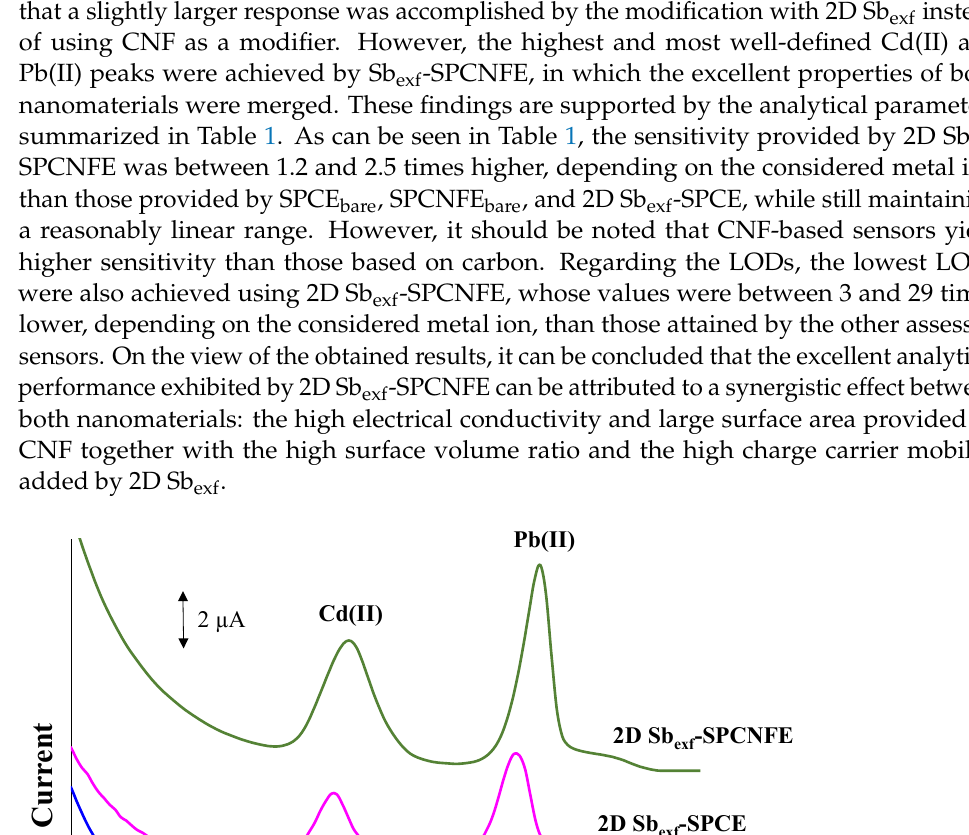
Figure 5. DP stripping voltammograms of 55 µg L − 1 of Cd(II) and Pb(II) were recorded at pH 2